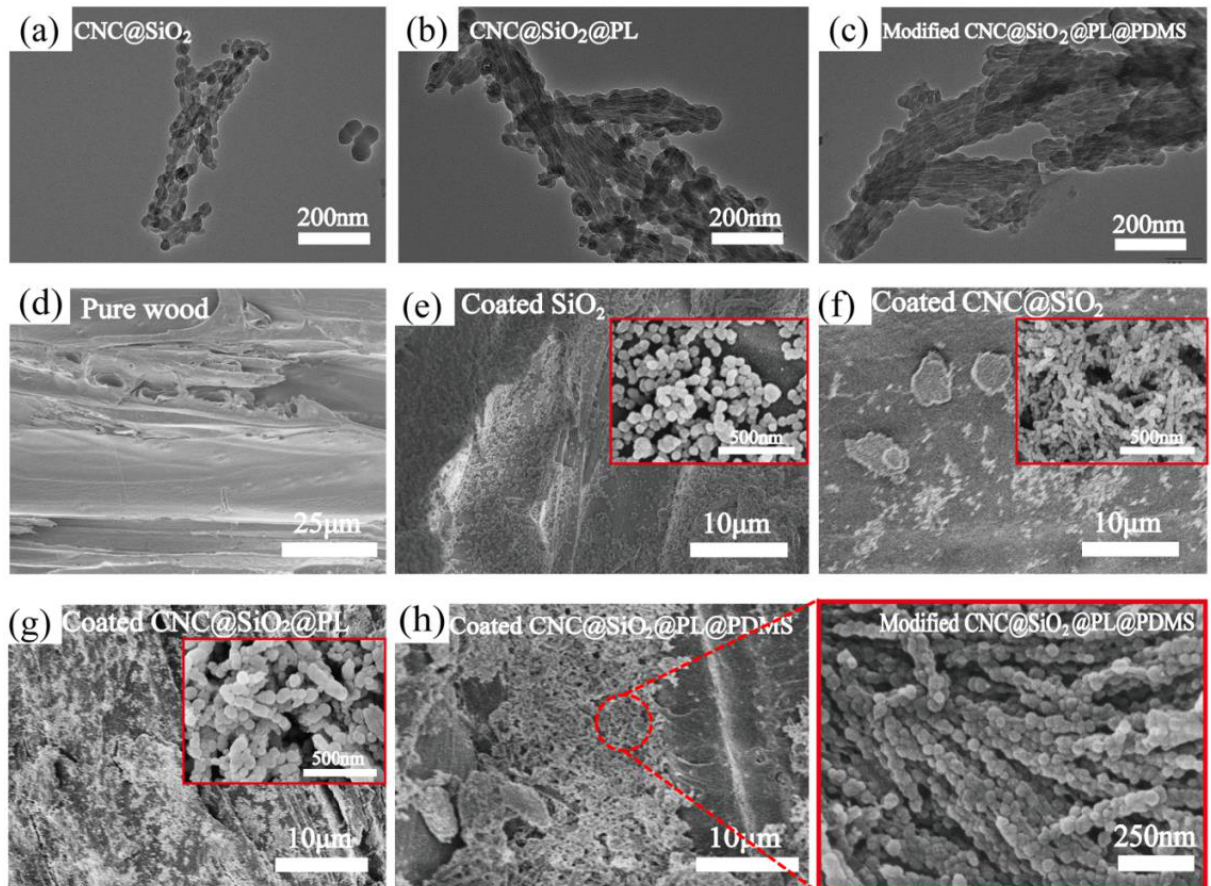
Figure 2. TEM images of ( a ) CNC@SiO 2 , ( b ) CNC@SiO 2 @PL, ( c ) modified CNC@SiO 2 @PL@PDMS coating; SEM images of ( d ) pure wood, ( e ) SiO 2 , ( f ) CNC@SiO 2 , ( g ) CNC@SiO 2 @PL, ( h ) CNC@SiO 2 @PL@PDMS coated woods. The illustrations in red box are the corresponding high mag- nification images.